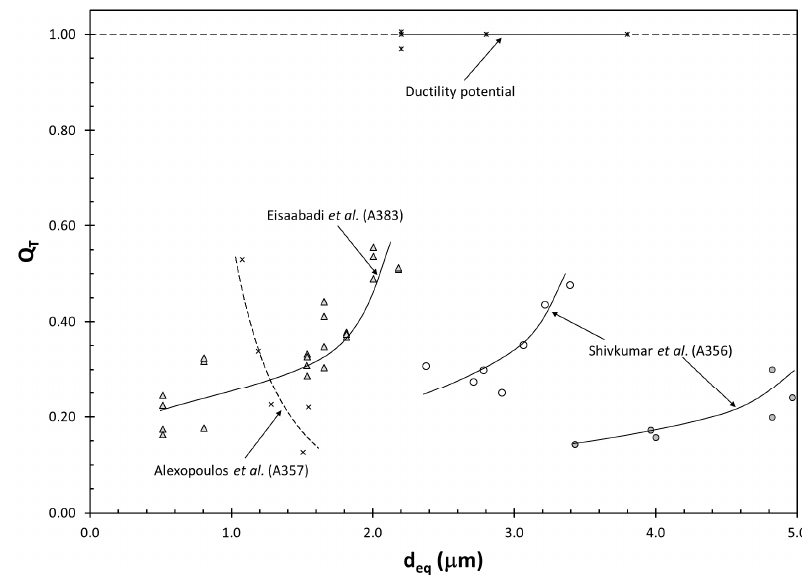
Figure 8. Correlations between Si particle size and ductility. The data from Shivkumar et al. are for unmodified A356 castings, with hollow points representing permanent mold castings and full points representing sand